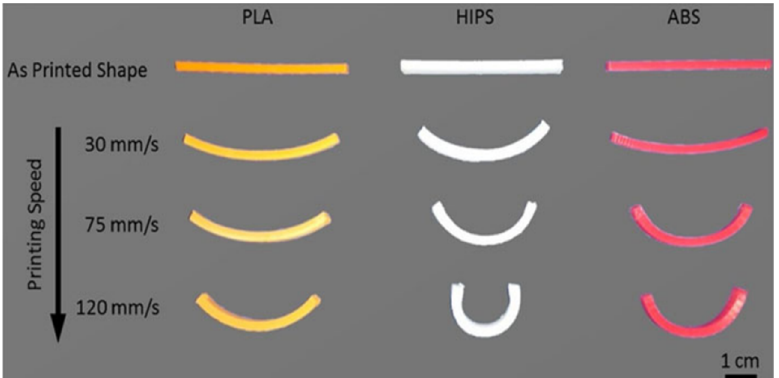
Figure 2. Effect of printing speed in different tested materials [48]. Material from: Rajkumar, A.R.; Shanmugam, K, Additive manufacturing-enabled shape transformations via FFF 4D printing, published (2018) (Springer Nature) reproduced with permission of SNCSC.